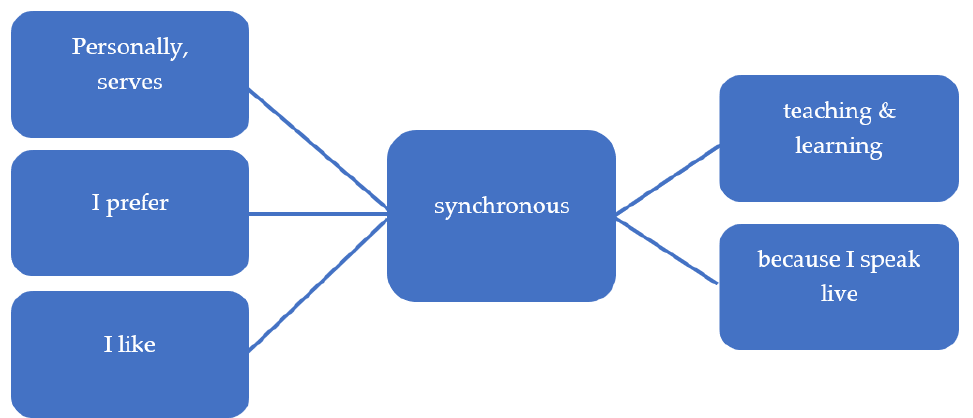
Figure 4. Reasons in favor of the physical school environment.